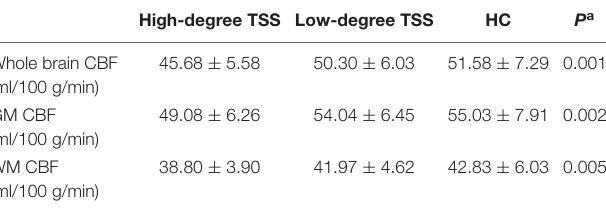
TABLE 2 | CBF measurement among the three